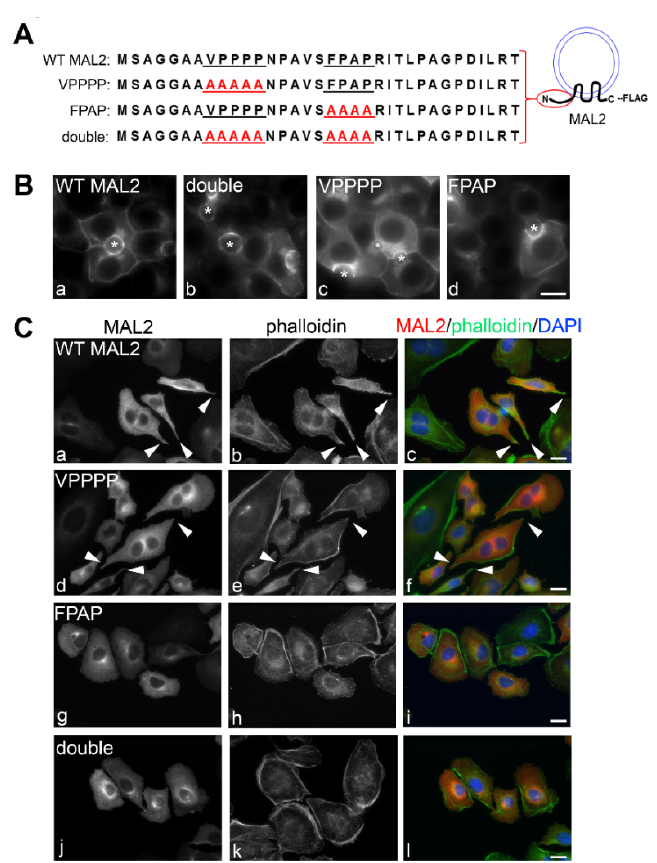
Figure 8. Mutations in a putative EVH1 recognition site decrease protrusion formation. ( A ) A diagram of the cytosolic, N-terminal amino acid sequence of MAL2 containing is shown. The two putative proline-rich EVH1 recognition sites are underlined and the single and double mutations are indicated in red. All constructs were FLAG-tagged at the C-terminus. ( B ) WIF-B cells expressing the wild type (WT) and mutant MAL2 proteins were immunolabeled for MAL2 with anti-FLAG antibodies. Asterisks mark bile canaliculi. ( C ) Clone 9 cells expressing wild type (WT) and the mutant MAL2 proteins were double labeled for MAL2 (with anti-FLAG antibodies) and actin (with phalloidin). Merged images are shown in c, f, i and l with DAPI labeling of nuclei. Arrowheads in a–f indicate surface protrusions in cells expressing wild type or VPPPP mutant MAL2. Bar = 10 µm.